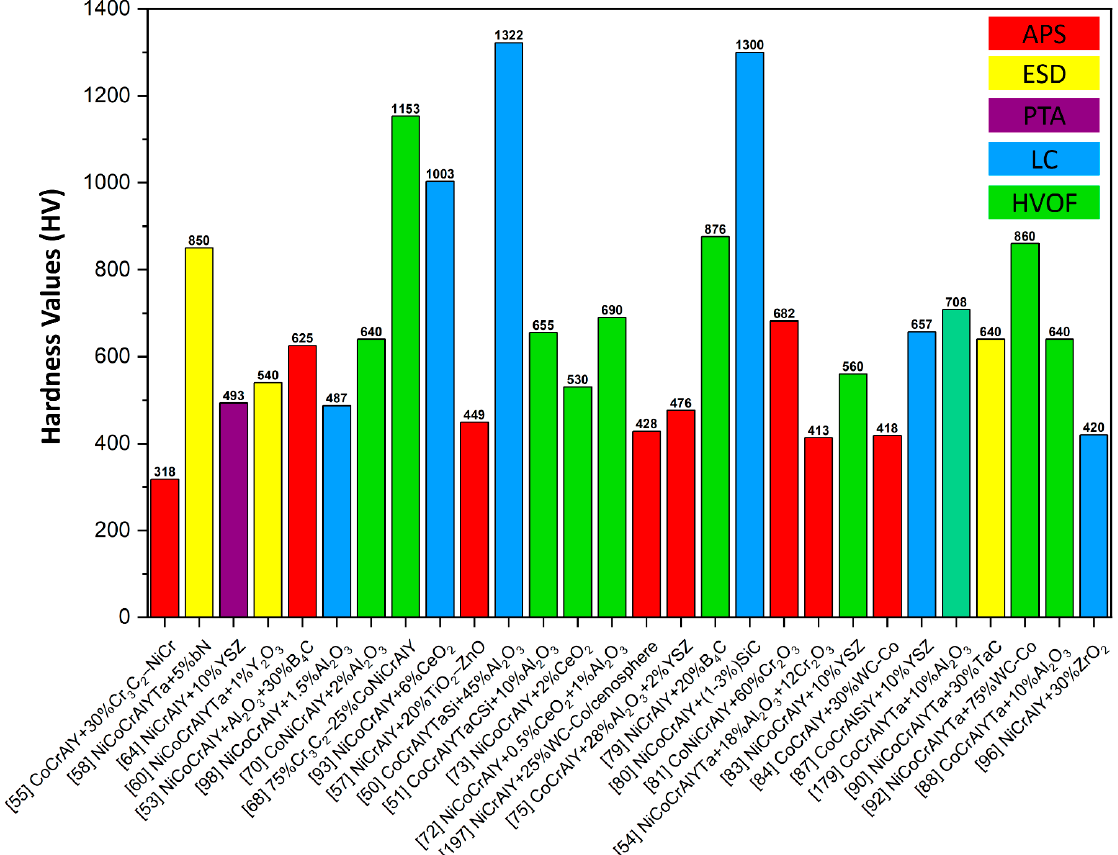
Figure 13. Hardness comparison of MCrAlY-based coatings reinforced with different materials.